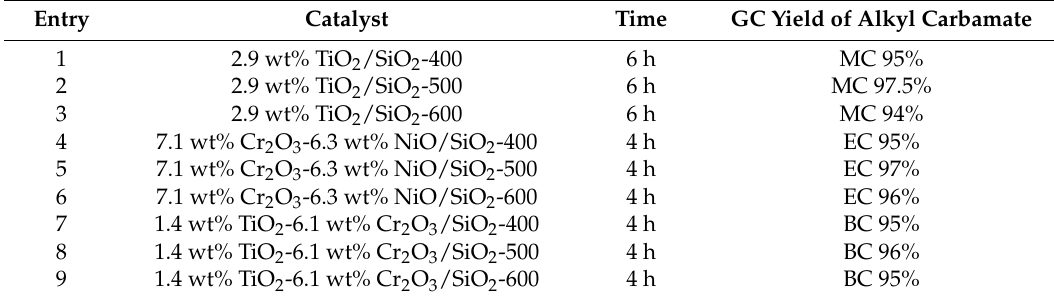
Table 3. Effect of calcinations temperature on the catalytic activity *.